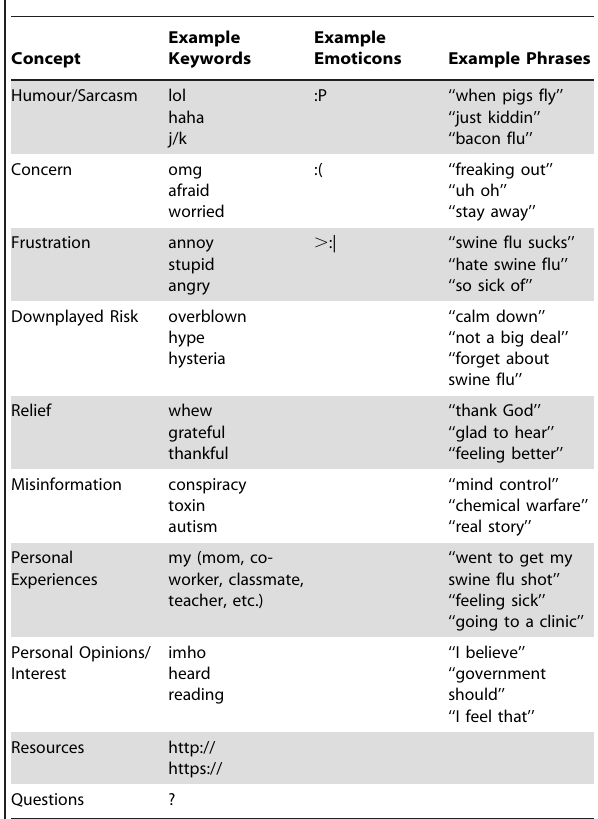
Table 5. Descriptions and Examples of Automated Coding Search Patterns.